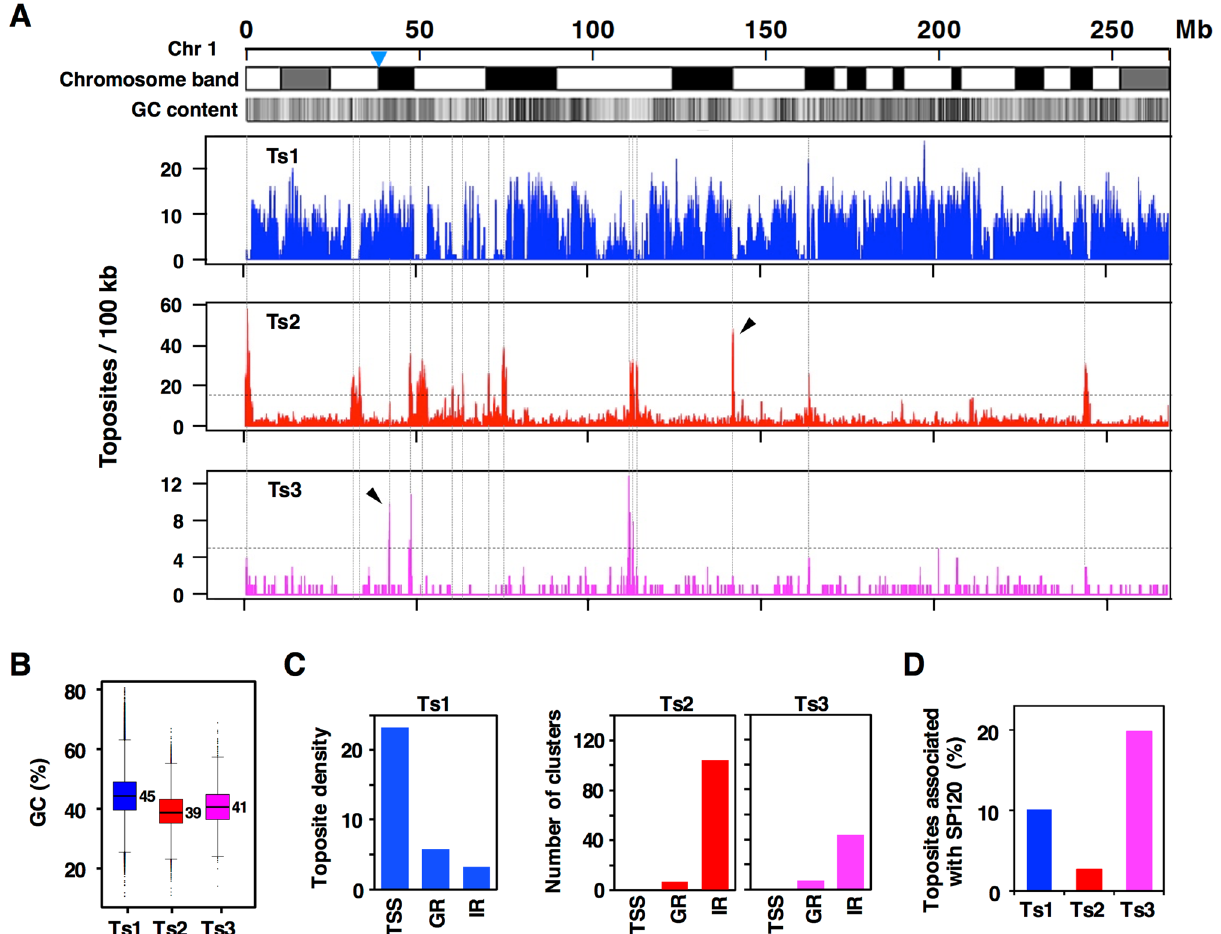
Figure 2. Genomic distribution of toposites and SP120 sites. ( A ) Density map of toposites on entire chromosome 1 as calculated by a sliding window algorithm (100 kb window, 10 kb step). Horizontal dotted lines show thresholds (15 for Ts2, 5 for Ts3) to define high-density peaks that are marked by vertical dotted lines. The position of centromere (p-q boundary) is indicated by nabla symbol and the arrowheads designate typical